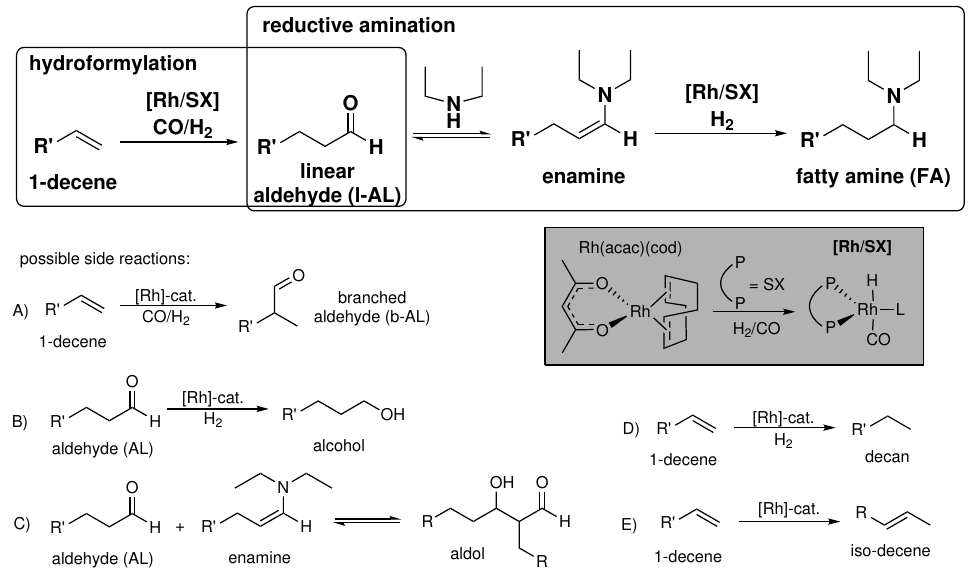
Figure 1. Rh-catalyzed hydroaminomethylation of 1-decene with diethylamine and possible side reactions observed: ( A ) hydroformylation yielding in branched aldehyde, ( B ) hydrogenation of aldehyde, ( C ) aldol reaction, ( D ) hydrogenation of 1-decene, and ( E ) isomerization of the double